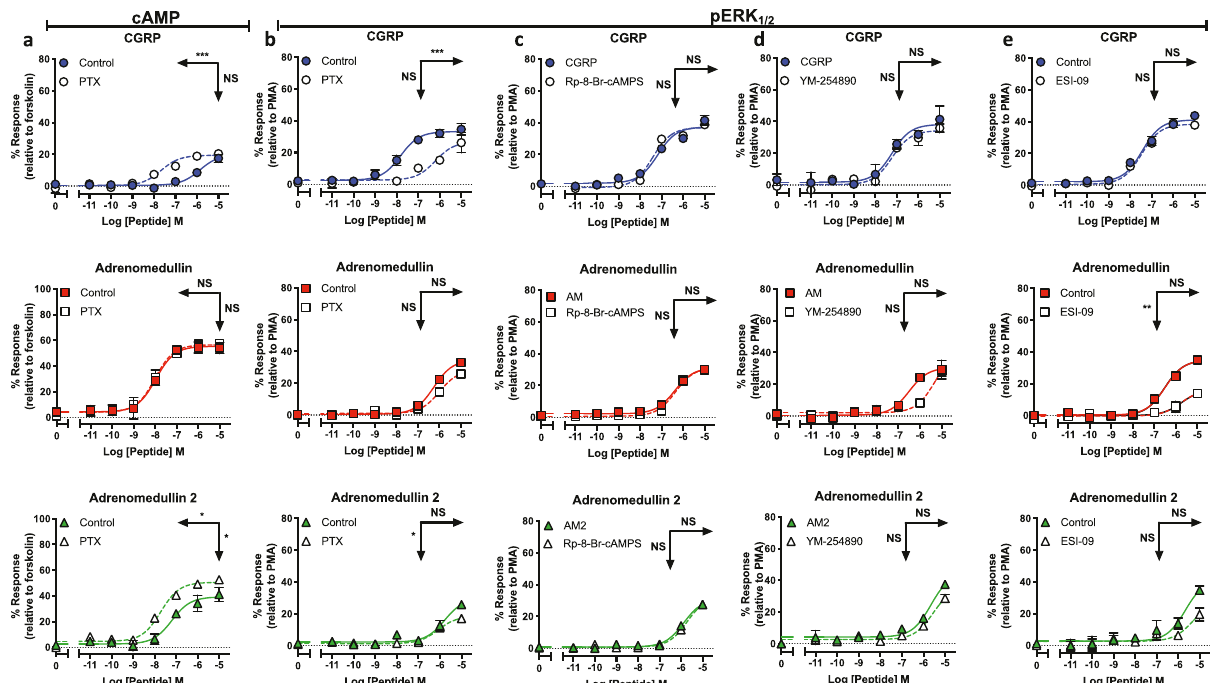
Fig. 2 Non-cognate G ɑ couplings at the AM1 receptor complex modulates cAMP accumulation and ERK 1/2 phosphorylation. a Characterisation of cAMP accumulation in response to stimulation by CGRP, AM, and AM2 with and without PTX treatment relative to forskolin (100 μ M) ( n = 4). b – e Characterisation of ERK 1/2 phosphorylation in response to stimulation by CGRP, AM, and AM2 with and without PTX treatment relative to PMA (10 μ M) ( n = 4) ( b ), with/ without Rp-8-Br-cAMPS (10 μ M) ( n = 3) ( c ), with/without YM-254890 (100nM) relative to PMA (10 μ M) ( n = 3) ( d ) and with/without ESI-09 (100 μ M) ( n = 3) ( e ). Data are analysed using a three-parameter non-linear regression curve. All data represent mean±SEM of n independent experiments. Statistical signi fi cance determined compared to control using an unpaired Student ’ s t test with Welch ’ s correction (* p <0.05; ** p <0.01; *** p <0.001). NS denotes no statistical signi fi cance observed. Rows show pEC 50 , and vertical arrows show E max statistical signi fi